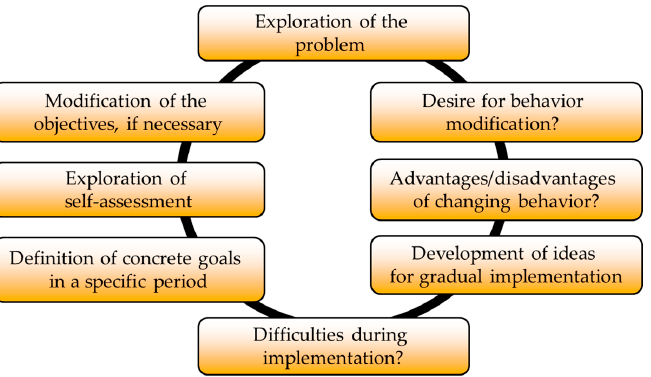
Figure 1. Procedure and content of motivational interviewing (MI)-counseling in the intervention group. Legend: Representation based on Information from [68] and adapted from [70].